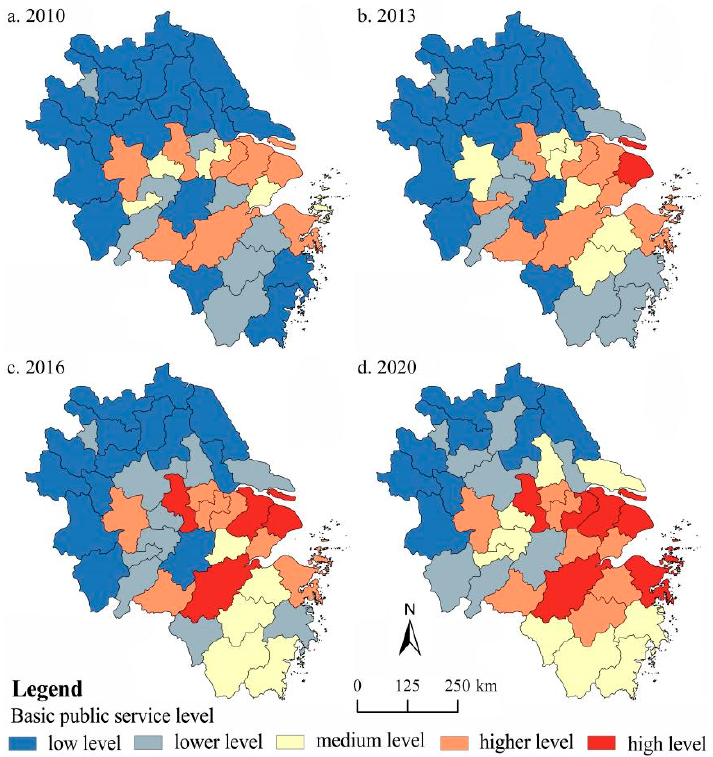
Figure 6. Spatial distribution pattern of the BPSL in the YRDR, 2010–2020.